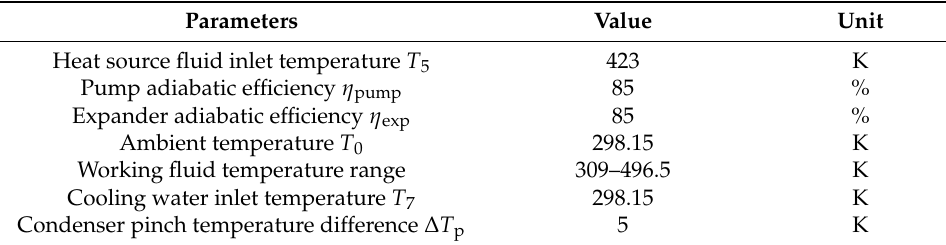
Table 2. Boundary parameters of the